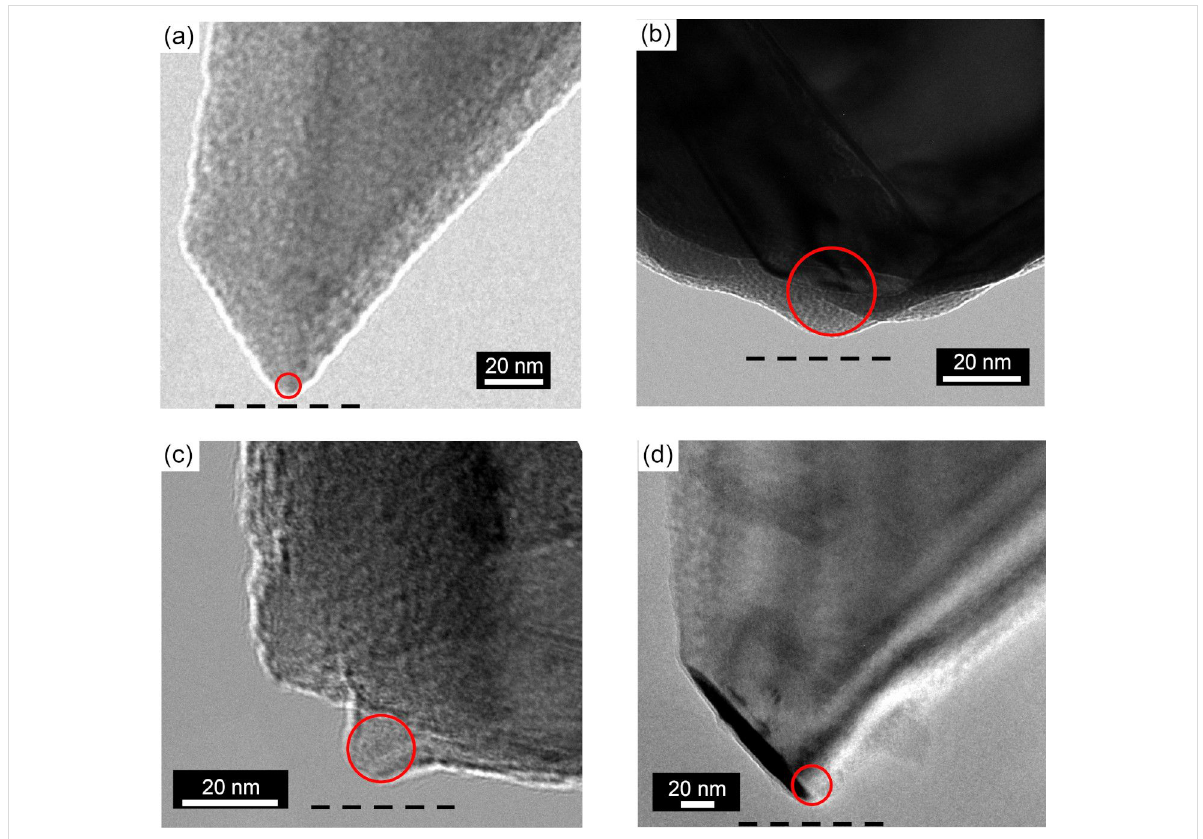
Figure 1: TEM image of four different tips employed in the dAFM experiments. The tips are referred to as (a) tip A, (b) tip B, (c) tip C, and (d) tip D in their acquired images. A circle in a red solid line has been drawn to emphasize the selected radius of each tip. Each TEM image has been rotated to compensate for the tilt angle of the AFM cantilever with respect to the plane of the sample surface, thus making a horizontal line in this figure the plane of the surface. The measured tip radii are as follows: (a) 3.0 ± 0.2 nm, (b) 25 ± 5 nm, (c) 10 ± 1 nm, and (d) 15 ± 1 nm and the adhesion force corresponding to the tips is as follows: (a) 4.0 nN, (b) 8 nN, (c) 5.5 nN, and (d) 6 nN. The black dashed line in the bottom indicates the HOPG surface plane.